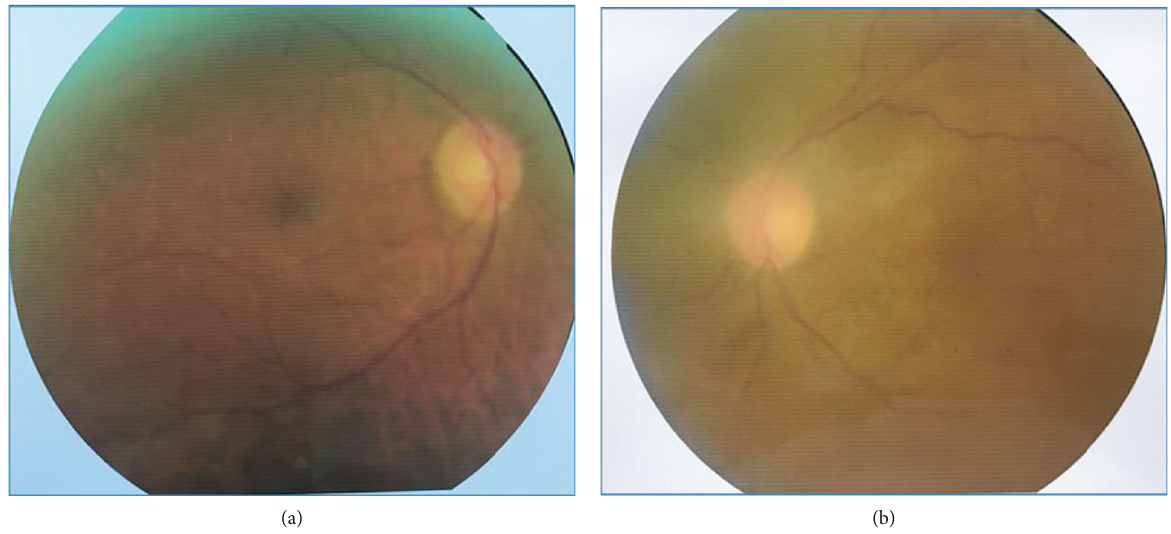
Figure 2: Color fundus photograph, one month after starting the antiviral therapy. (a) Right eye: multiple subretinal punctate lesions resembling Drusen scattered on the temporal side of the fovea. (b) Left eye: vitreous haziness, disc paleness, and resolving retinitis associated with pigmentary change at the macular area and superior to the disc.